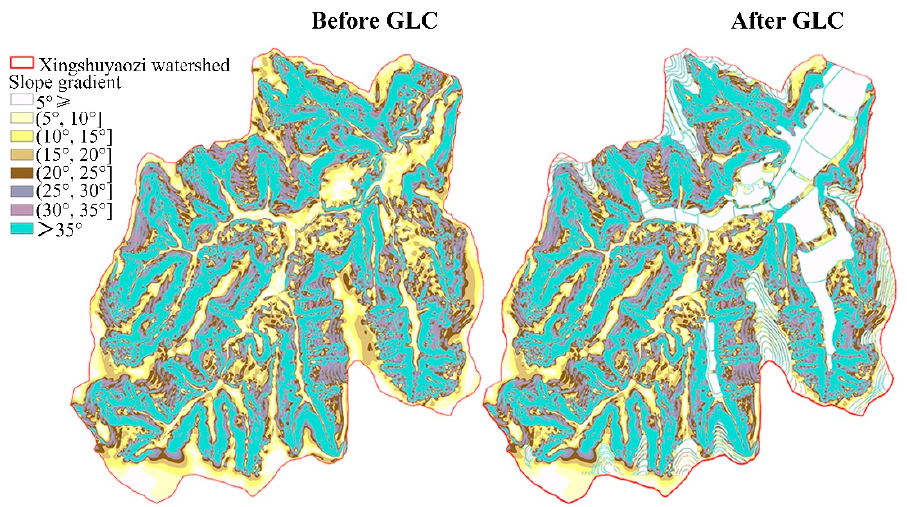
Figure 10. Slope gradient in Xingshuyaozi watershed before GLC (in 2013) and after GLC (in 2019).